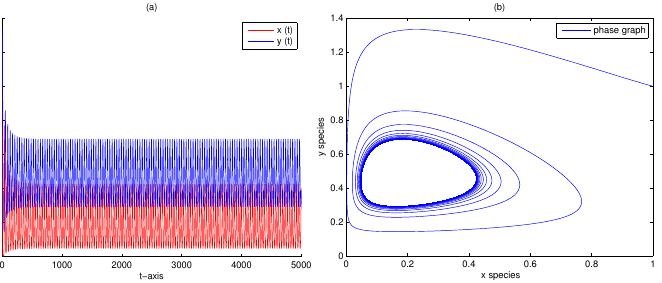
Figure 8. The equilibrium status E ∗ of (2) with τ = 0.5 is numerically unstable: ( a ) time-series curves of x ( t ) and y ( t ) , ( b ) is the phase diagram.